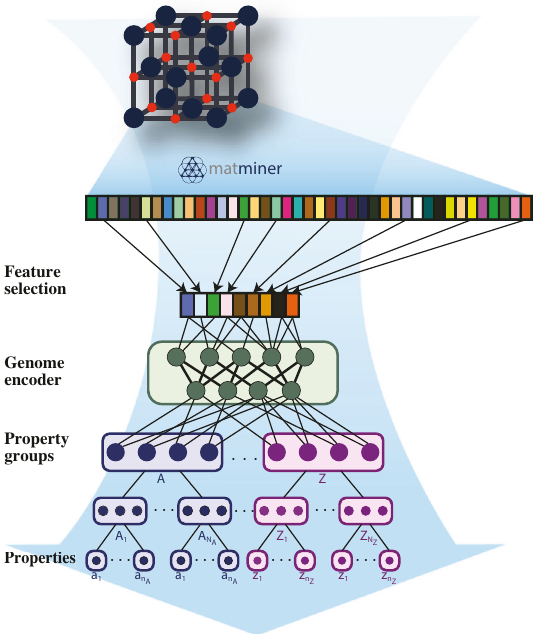
Fig. 1 Schematic of the MODNet model. The feature selection on matminer is followed by a hierarchical tree-like neural network. , … , Z 1 , … , Z N (e.g., Young ’ s modulus, Various properties A 1 , … , A N A Z refractive index, ...) are gathered in groups from A to Z of similar nature (e.g., mechanical, optical, ...). Each of these may depend on a parameter (e.g., temperature, pressure, ...): A ( a ), … , Z ( z ). The properties are available for various values of the parameters a 1 , … , a n , … , z 1 , … , z n . The fi rst green block of the neural network A Z encodes a material in an appropriate all-round vector, while subsequent blocks decode and re-encode this representation in a more target-speci fi c